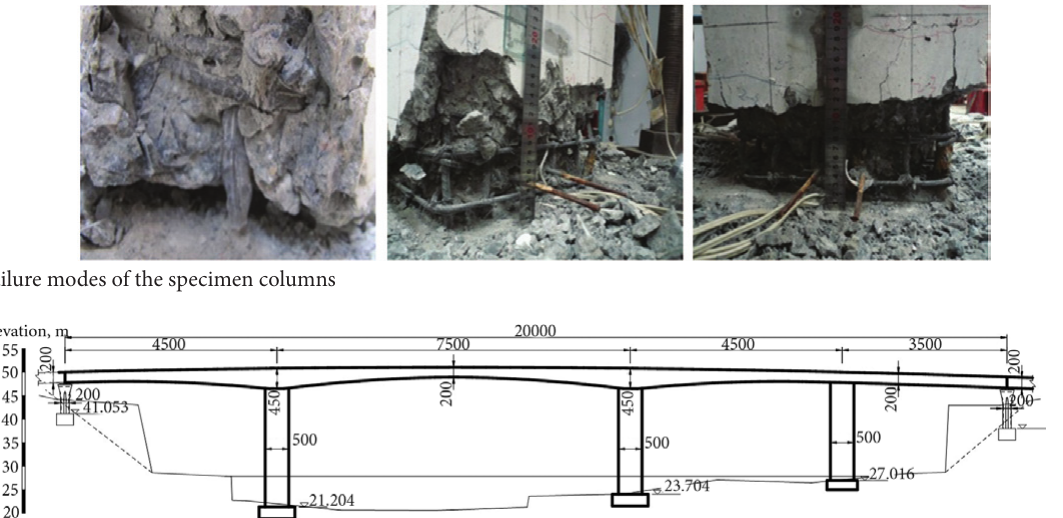
Fig. 10. Experimental and calculation results